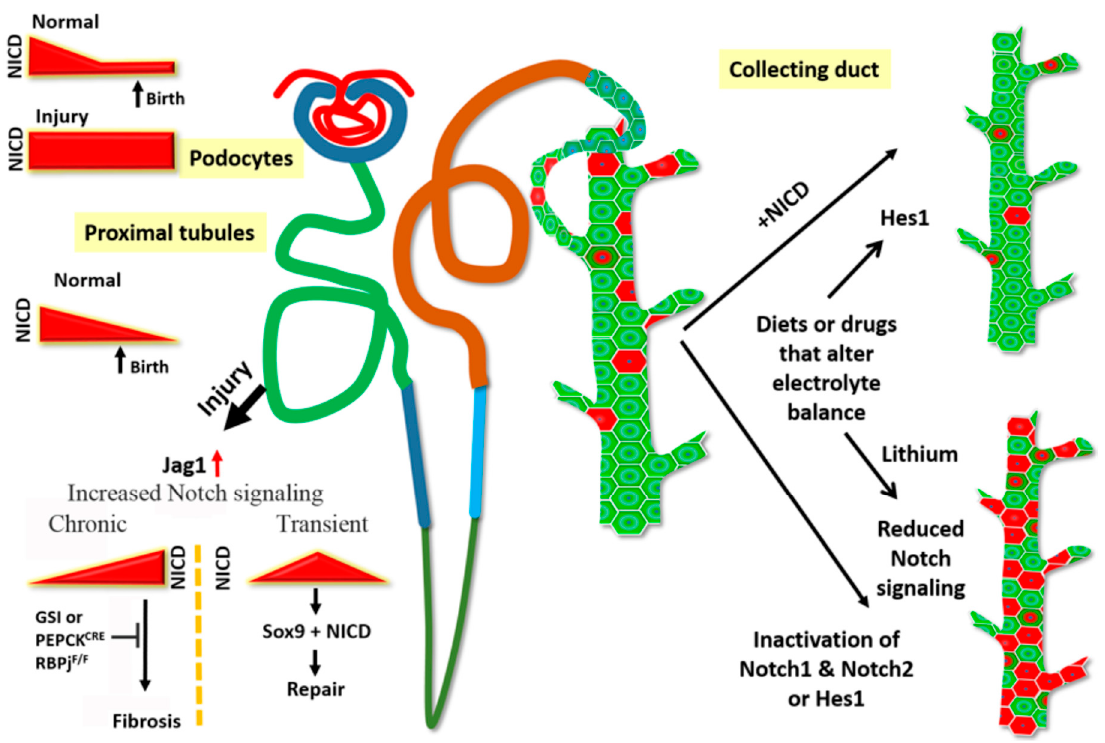
Figure 2. Notch signaling in the adult kidney. Notch signaling is active during nephrogenesis, and the signaling is attenuated after birth in the normal kidney. Reactivation of sustained Notch signaling in the adult kidney either due to genetic activation of Notch signaling or triggered by injury promotes pathological states. Ectopic expression of Notch in mature podocytes results in glomerular dysfunction. The proximal tubules are highly susceptible to injury, and following injury, Jag1 expression increases to activate Notch signaling. Continued high (chronic) Notch signaling leads to fibrosis. This progression can be slowed by blocking Notch signaling either by Gamma secretase inhibitors (GSIs) or by genetic ablation of Notch signaling (PEPCK CRE ; RBPj f / f ). However, a transient increase in Notch after injury maybe beneficial as it initiates the repair process mediated by Sox9 + epithelial cells. In the collecting duct, Notch signaling is required to maintain principal cells (green) in their selected fate. Either increase or decrease of Notch signaling perturbs the ratio of principal cells to intercalated cells seen in normal kidney. Diets such as low potassium or drugs such as lithium also increase intercalated cell numbers at the expense of principal cells, and possibly do so by altering Notch signaling activity.